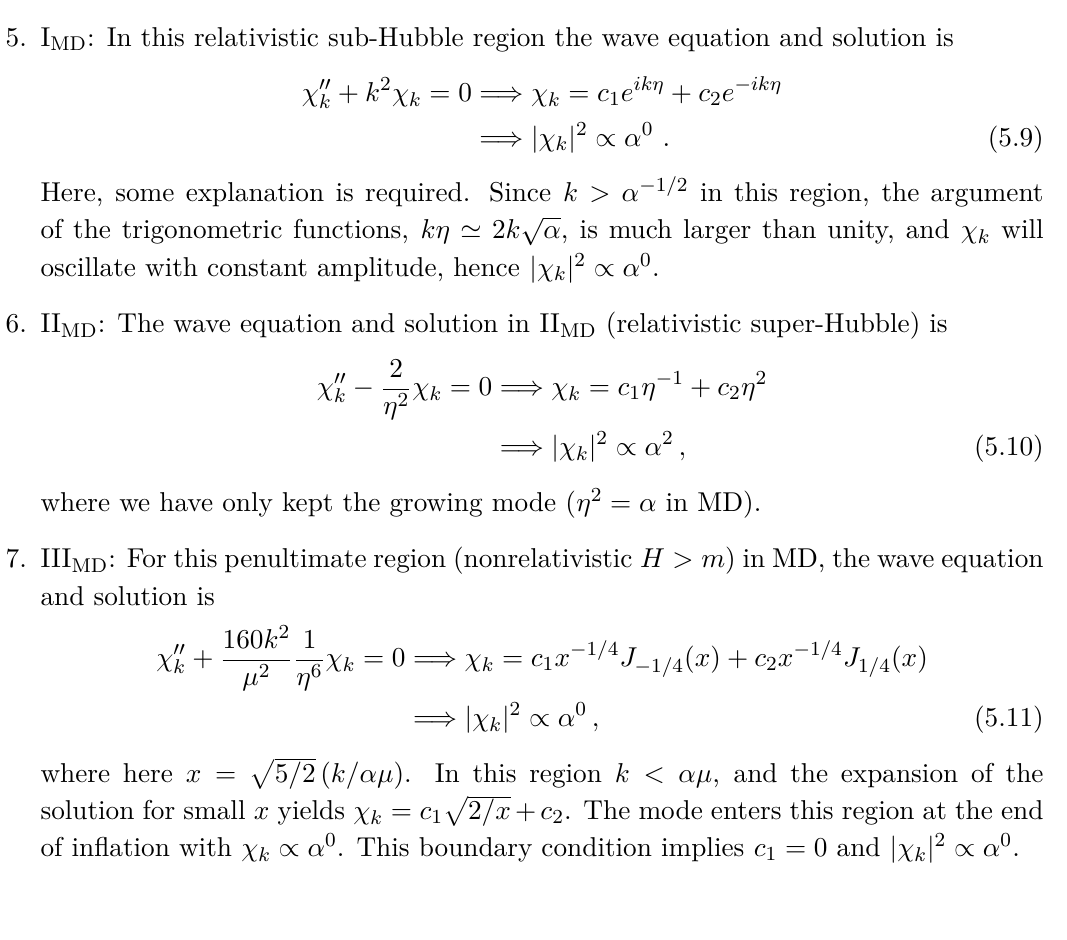
Figure 4 . Regions in the k – α plane for evolution in the dS phases. In different regions we indicate the scaling of | χ k | 2 . The line denoted k = α the line the mode is sub-Hubble and below it is super-Hubble. The line k = αµ is the line that devides the relativistic ( k > am ) and nonrelativistic ( k < am )